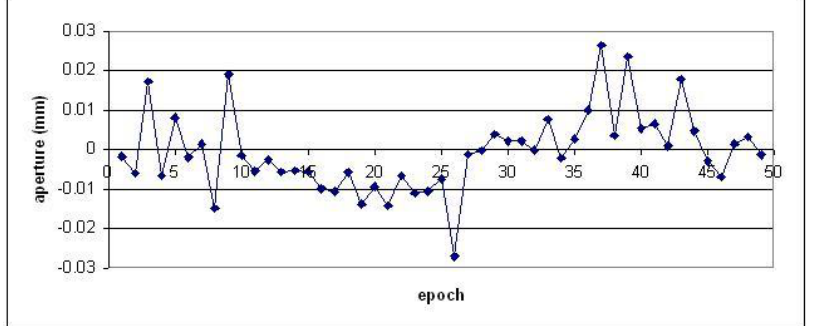
Figure 12. Comparison between mechanical and image-based measurements for a target-less